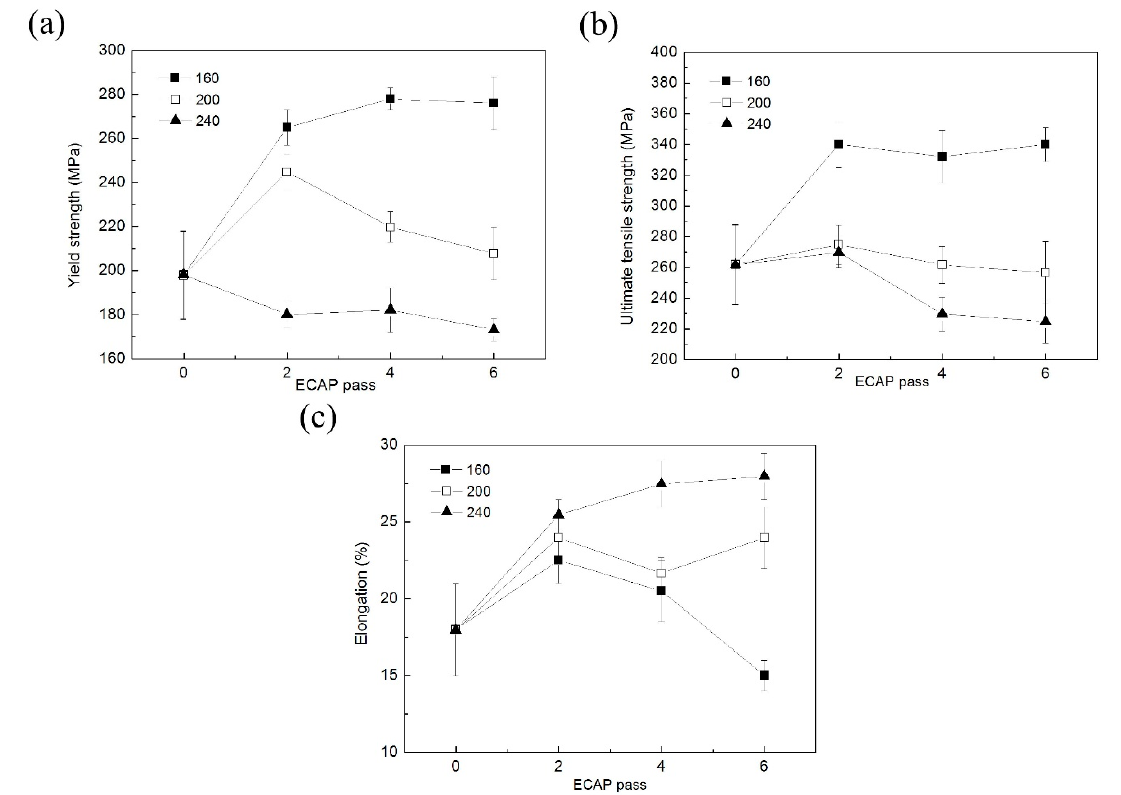
Figure 1. Mechanical properties of Mg-6Zn alloys before and after equal channel angular pressing (ECAP) processing: ( a ) yield strength, ( b ) ultimate tensile strength and ( c ) elongation.